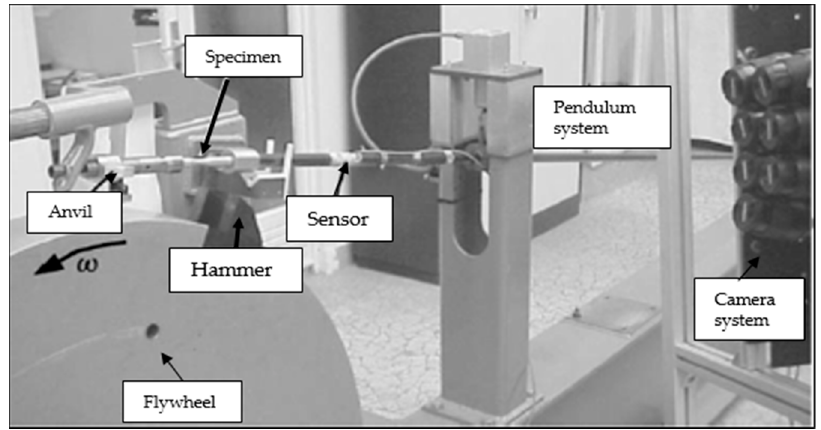
Figure 4. Flywheel and its long pendulum system (load sensor) (the figure is reproduced from [43], with the permission from authors (open access), 2007).